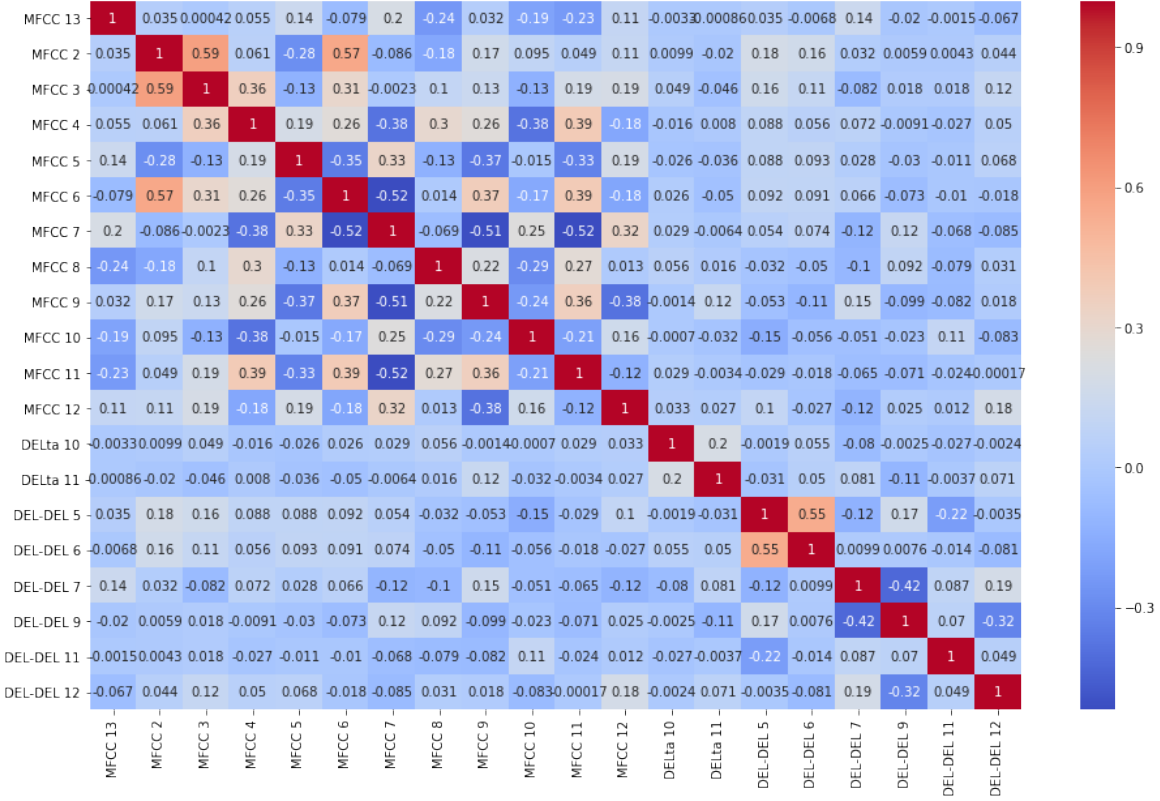
Figure A3. Correlation matrix of the 20–dimensional highest–ranking feature vector obtained by the SVM-RFE